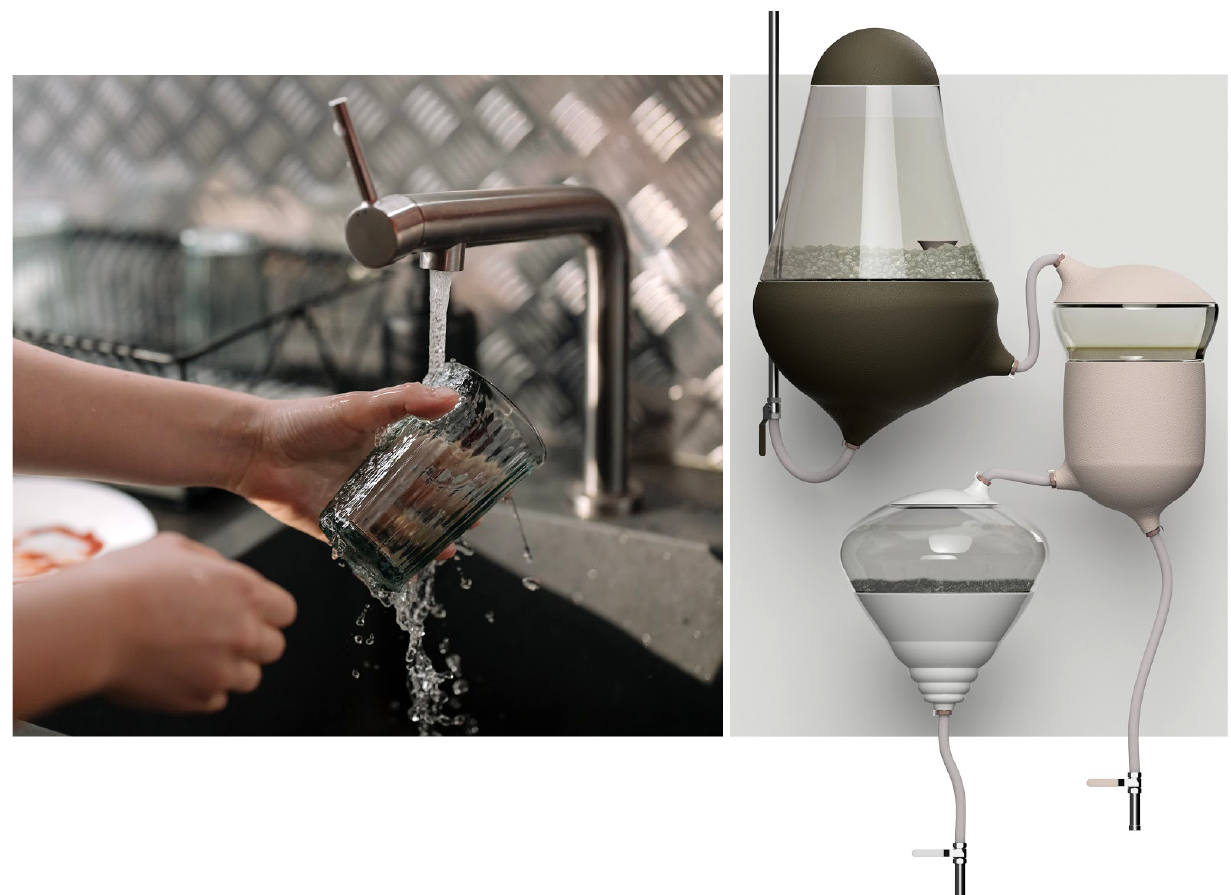
Figure 2a. The abundance of water as experienced in a conventional water tap. Image credits: cottonbro. 2b. Household Water Fraction System. Image credits: David